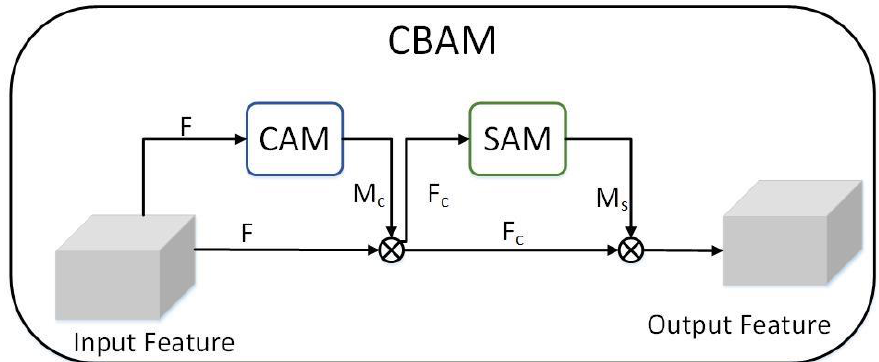
Figure 2. Structure diagram of CBAM (CAM stands for channel attention, SAM stands for spatial attention; F : input feature map; M c : feature map after F passing through CAM; F c : feature map after feature fusion of F and M c ; M s : feature map after F c passing through SAM).